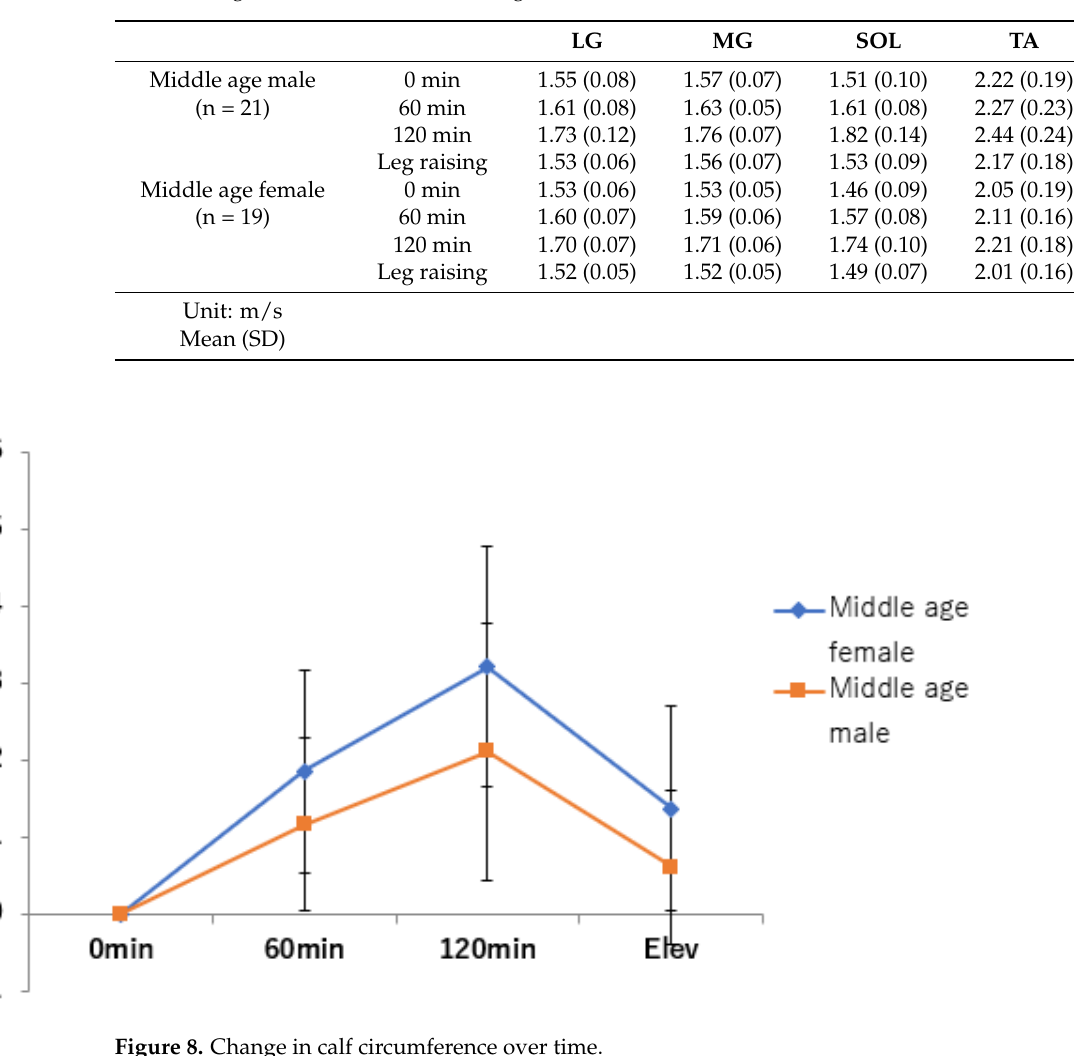
Table 2. Shear wave velocity of LG, MG, SOL, and TA over time. Unit: m/s. Average ± SD. LG: Lateral gastrocnemius; MG: Medial gastrocnemius; SOL: Soleus; TA: Tibialis anterior.